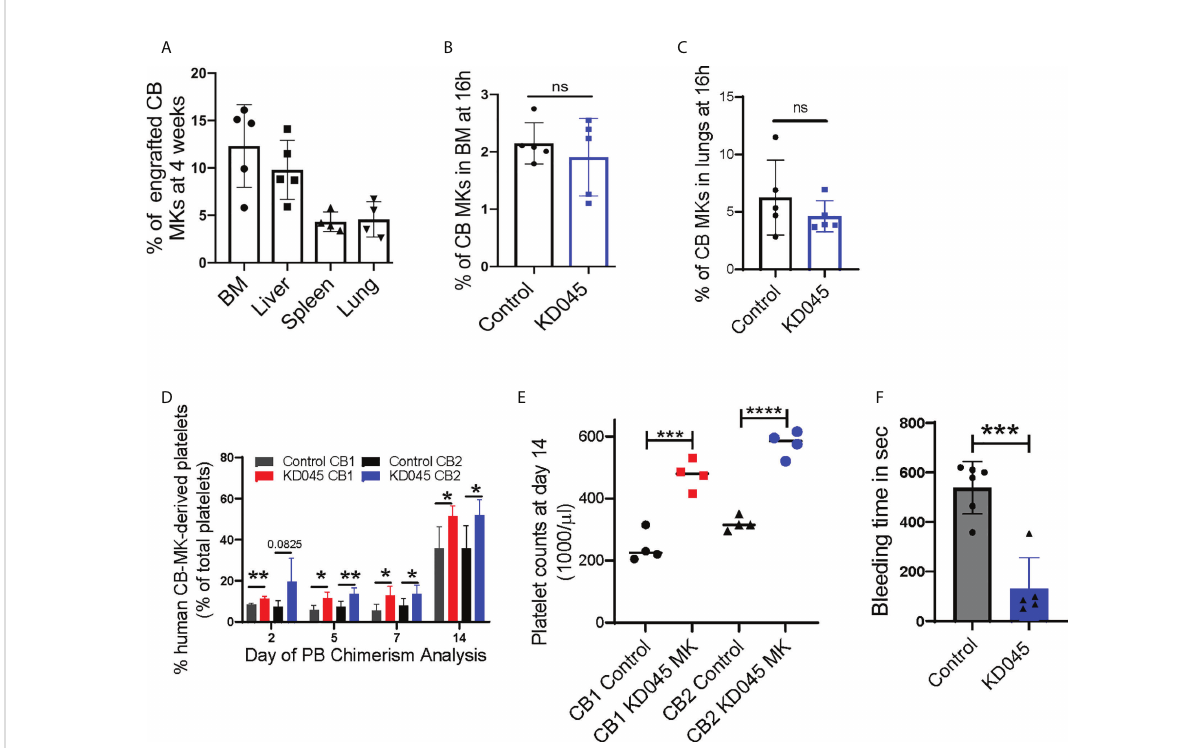
FIGURE 4 ROCK inhibition increases MK platelet production in an in-vivo thrombocytopenia model. (A) Percentage CB hCD41a+ hCD42+ chimerism in various niches of sub-lethally irradiated NSG mice at 1-month after infusion of 7 x 10 6 CB-MKs that were pretreated with KD045 (n=4-5 mice). (B, C) Percentages of untreated or KD045 pretreated CFSE+ CB-MKs (in total Ter119- BM live cells) that homed to mice bone marrow (BM) (B) and lungs (C) at 16h post 5 x 10 6 CB-MK transfer (n=5 mice per group). (D) CB-MK-derived circulating platelet chimerism in mice blood at 2, 5, 7 and 14 days after transfer of 15 x 10 6 MKs that were either untreated or pretreated with KD045 prior to transfer (n=4-5 mice per group from 2 different CB donors, *p < 0.05 and **p < 0.01). (E) Platelet counts in mice blood at 14 days after transfer of 15 x 10 6 MKs that were either untreated or KD045-pretreated prior to transfer (n=4 mice per group, ***p < 0.001 and ****p < 0.0001). (F) Tail bleeding time in seconds of sub-lethally irradiated NSG mice 14 days after infusion of KD045-pretreated MKs, compared to bleeding time of mice that did not receive MKs (n=5-6 mice per group, ***p < 0.001). All statistical analyses completed with unpaired t-tests. "ns" means not signi fi